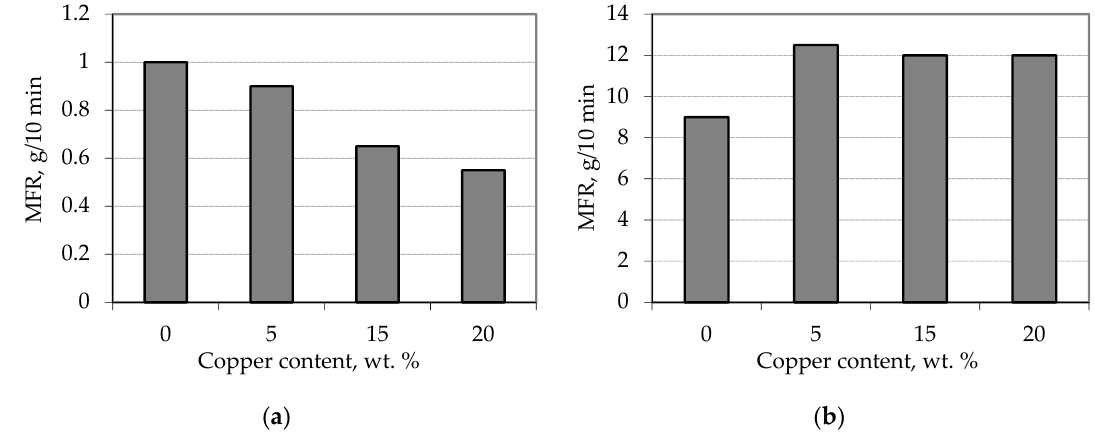
Figure 19. Dependence of MFR of metal-filled polypropylene composites on copper content. ( a ) Т = 190 °C, Р = 10 kg; ( b ) Т = 230 °C, Р = 5 kg.